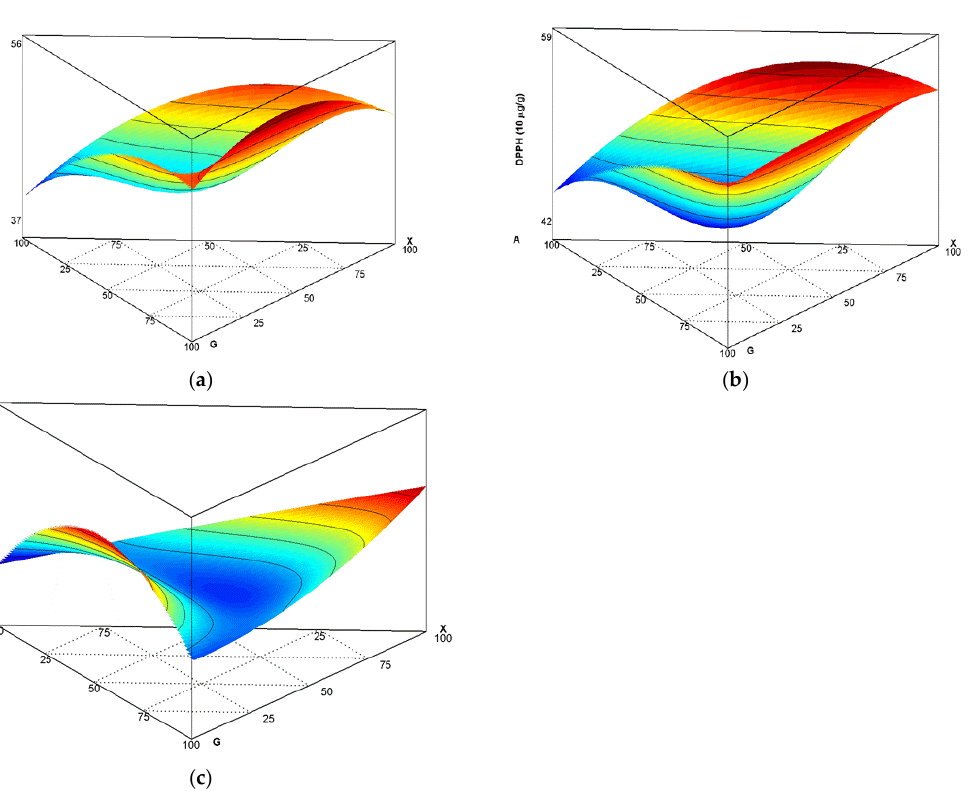
Figure 3. Antioxidant capacity with 2,2 difenil-1-picrilhidrazil (DPPH) radical inhibition for ( a ) 5 µg/mL, ( b ) 10 µg/mL, and ( c ) 30 µg/mL (sample), in matrix I (formed by IN, L, and MX).